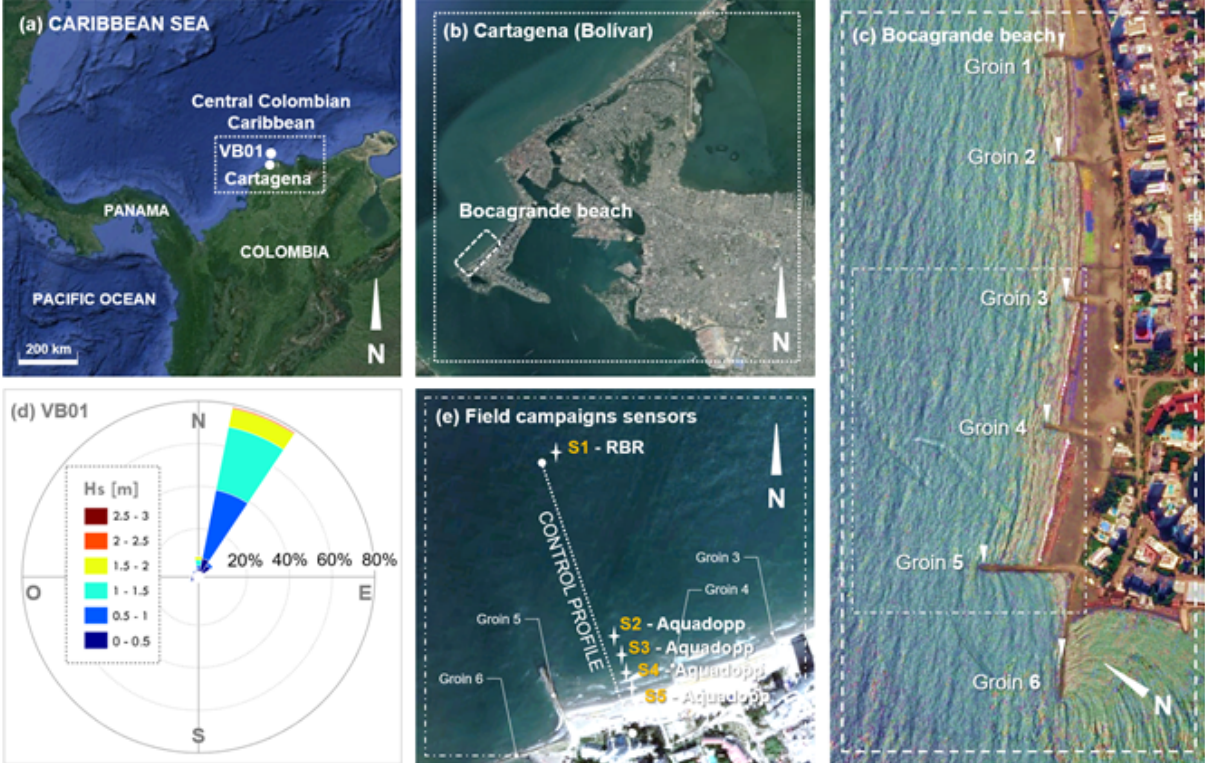
Figure 1. Location of study area: (a) location of Cartagena in the Colombian central Caribbean and virtual buoy 01 (VB01) (10 ◦ 40 (cid:48) 1.12 (cid:48)(cid:48) N, 75 ◦ 30 (cid:48) 0.00 (cid:48)(cid:48) W); (b) location of Bocagrande Beach in Cartagena de Indias; (c) studied area (computational domain of XBeach) of Boca- grande beach; (d) wave rose extracted from VB01; (e) instrumental setup during field campaigns (S1: sensor 1 – RBR; S2, S3, S4 and S5: sensors 2, 3, 4 and 5, respectively – Aquadopps) – the reader is referred to Cueto and Otero (2020) for a detailed description of sensors location, depth and measurement rates. Map base images retrieved from © Google Earth and modified by the authors.